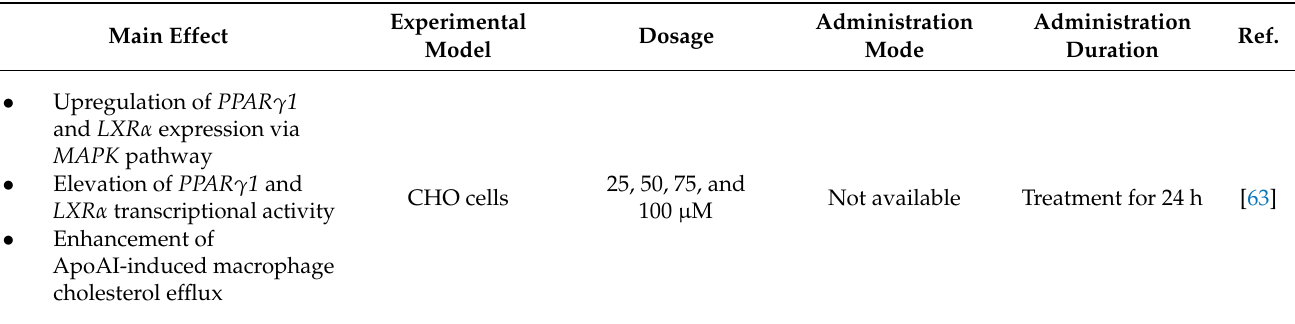
Table 5. The effects of sesamol on macrophage cholesterol